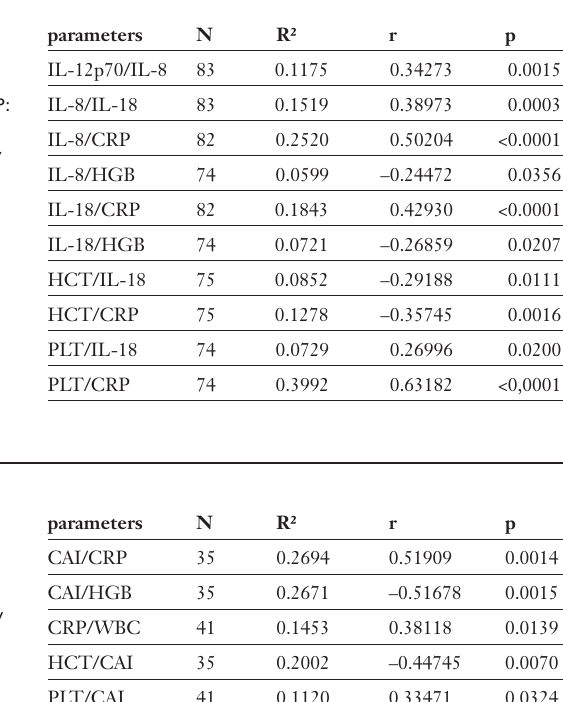
Correlation analysis in patients with Crohn’s disease (CRP: C-reactive protein, RBC: red blood cells, HGB: haemoglobin, HCT: haematocrit, PLT: platelets, WBC: white blood cells).